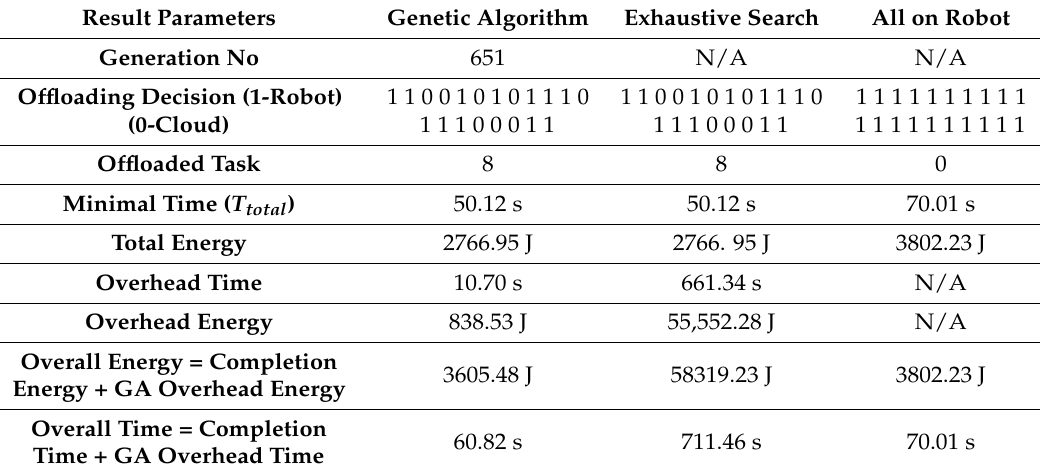
Table 4. Performance comparison for 20-node task flow (Minimise: T total